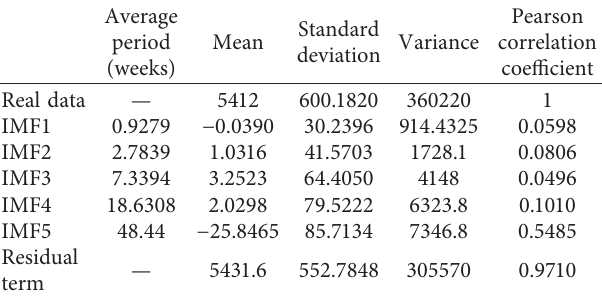
Table 2: Statistical recognition of the decomposition